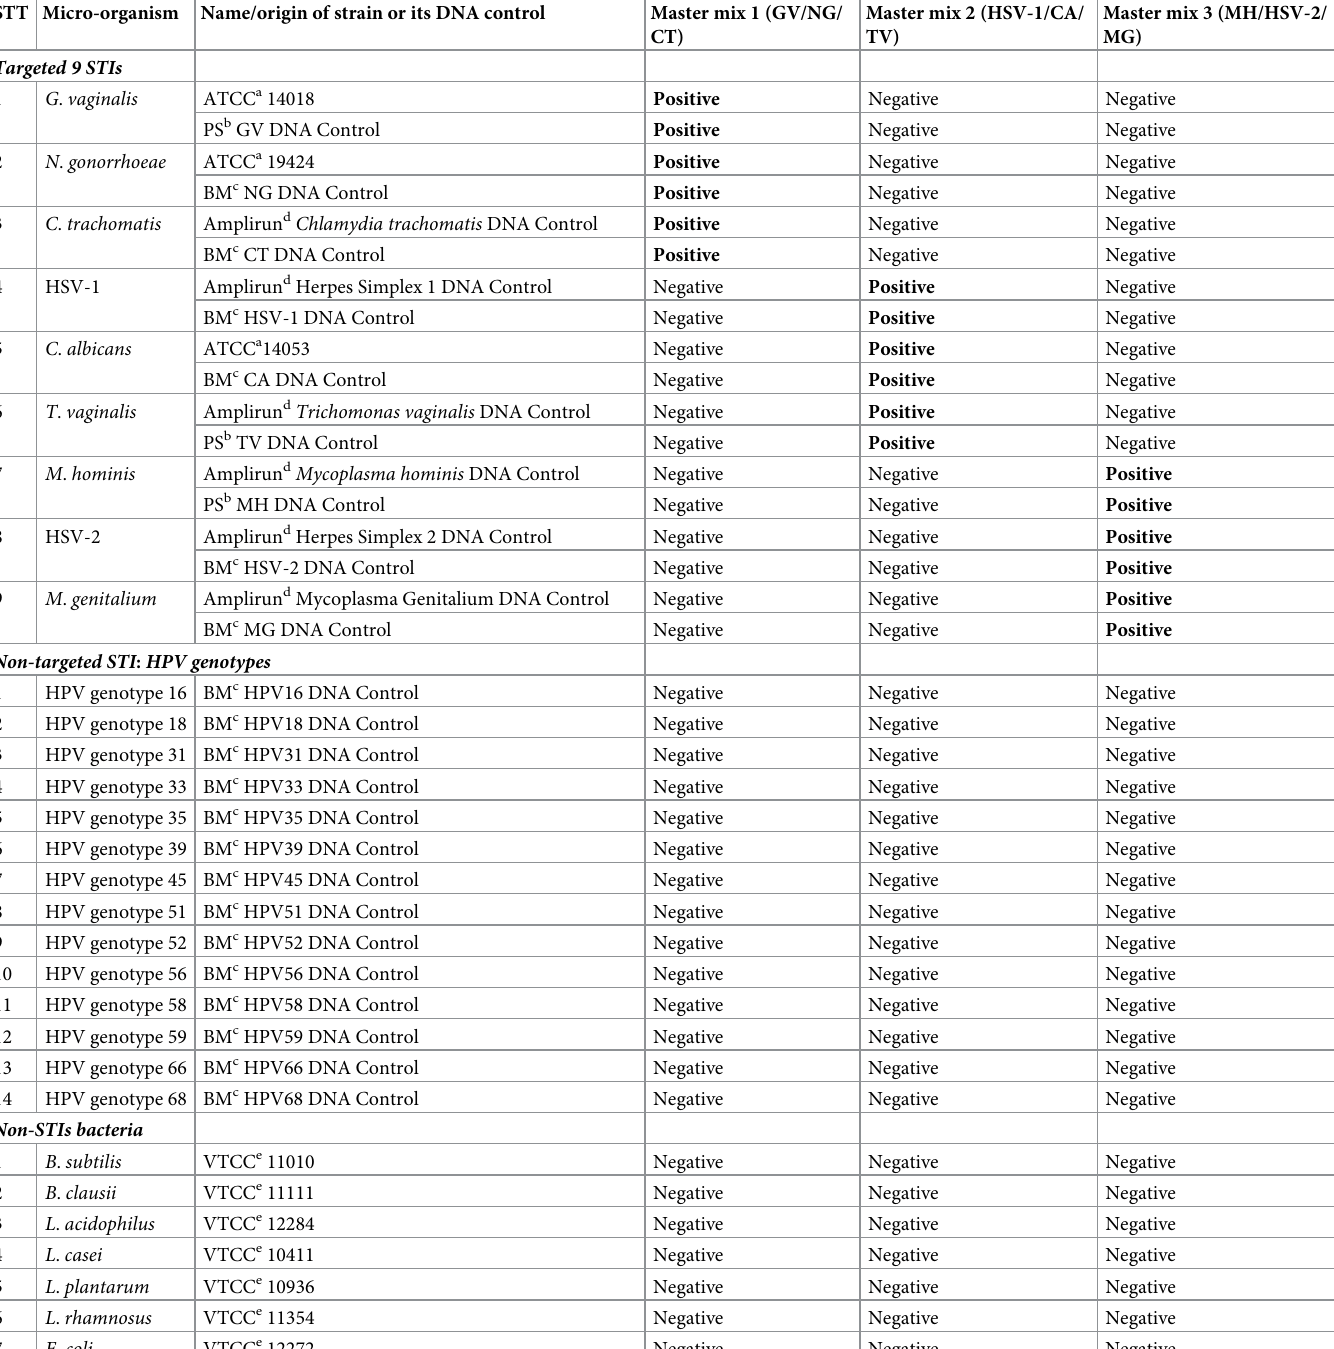
Table 2. Analytic cross-reactivity of “in-house” real-time PCR assay for nine STIs. STT Micro-organism Name/origin of strain or its DNA